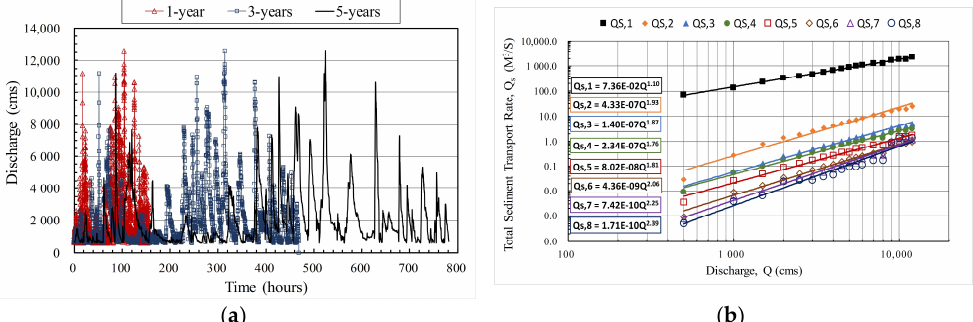
( b ) Figure 6. Bed representation for the primary model: ( a ) Bed gradation zones to specify the sediment gradations on the bed (background map source: maps.nlsc.gov.tw web map service). ( b ) Cumulative sediment size distribution for various bed zones. 3.5. Boundary Conditions A t the upstream boundaries of both models, a time series flow hydrograph and a sediment supply rate are specified. The recorded hourly flow discharge in the 18-year period of 1998 to 2015 at Ji-Lu Bridge and Ji-Ji Weir are used to develop the 1-year, 3-year, and 5-year events for the primary model. The design hydrographs of 1-year, 3-years, and 5-year events are plotted in Figure 7a. The simulation time period is 156, 470, and 782 hours, respectively, for the three designed events. The simulated sediment rates of the assistance model at the Ji-Lu Bridge are processed to produce the sediment supply condition of all size classes for the primary model. The generated data